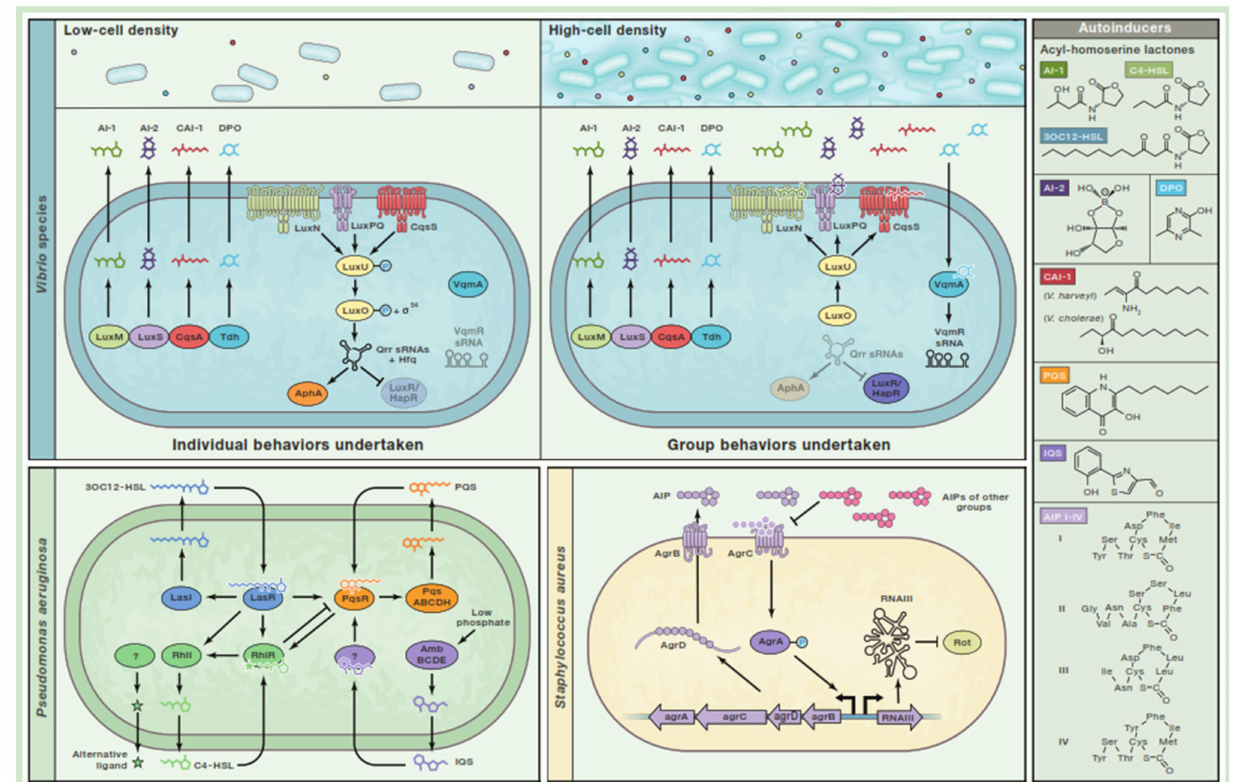
Figure 3. Bacterial quorum sensing. In Vibrio species, when autoinducer (AI) levels are low due to low cell density, the AI cognate receptors activate a phosphorylation cascade that leads to the activation of transcription factor AphA, a mediator of individual cell behaviors. In contrast, at high cell density (HCD), LuxM, LuxS, CqsA, and Tdh synthases produce high levels of AI-1 (3OHC4-homoserine lactone (HSL)), AI-2 ((2S,4S)-2-methyl-2,3,3,4-tetrahydroxytetrahydrofuran-borate), CAI-1 ((Z)-3- aminoundec-2-en-4-one), and DPO (3,5-dimethylpyrazin-2-ol), respectively. The AIs bind their respective receptors leading to the abrogation of AphA activity and LuXR or HapR activation. Under these conditions, Vibrio species initiate group behaviors. P. aeruginosa uses four pathways that employ cytoplasmic AI receptors acting as transcription factors when bound by AIs. LasI/LasR and RhII/RhIR produce and detect 3OC12-HSL and C4-HSL, respectively, while PQS (2-heptyl-3- hydroxyl-4-quinolone) produced by PqsABCDH is bound by the PqsR receptor. The fourth system is dependent on the production of IQS (2-(2-hydroxyphenyl)-thiazole-4-carbaldehyde) by AmbBCDE and subsequent activation of the Pseudomonas quinolone signal (PQS) system by IQS via an unknown receptor. At HCD, a precursor peptide (AgrD) is processed by AgrB into inducing peptide (AIP), which, when exported, activates AgrC, an autokinase receptor, which then phosphorylates AgrA. Phosphorylated AgrA induces the production of a regulatory RNA that controls group